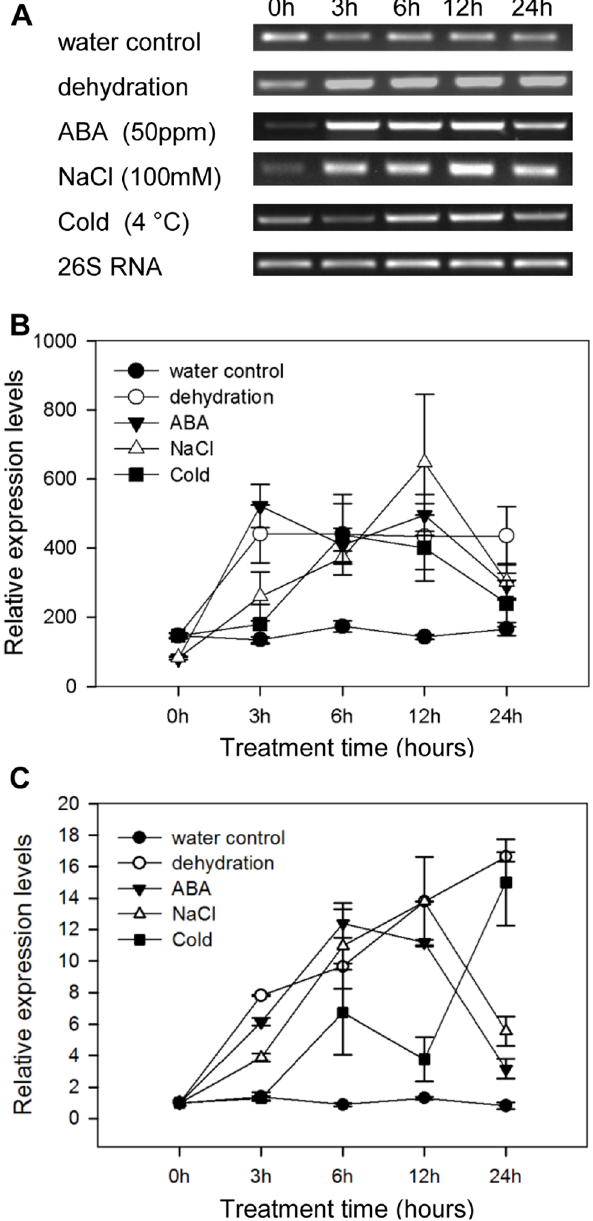
Figure 4. Expression of PhHD-Zip in petunia flower under abiotic stress. Petunia flowers harvested at anthesis were placed in tubes with water, without water, with 50 ppm ABA, or with 100 mM NaCl at room temperature, or in water at 4 u C. A. A representative gel image from semi-quantitative PCR of RNA isolated from corollas harvested at intervals. 26S RNA: the internal control. Samples were analyzed after 30 cycles for PhHD-Zip, and after 24 cycles for 26S RNA. B. Relative expression levels of PhHD-Zip (quantification of the gel pictures; error bars show SE of the means of three biological replicates). C. Relative expression levels of PhHD-Zip determined using the same RNA samples, but using real-time quantitative PCR (error bars correspond to SE of the means of three biological replicates).